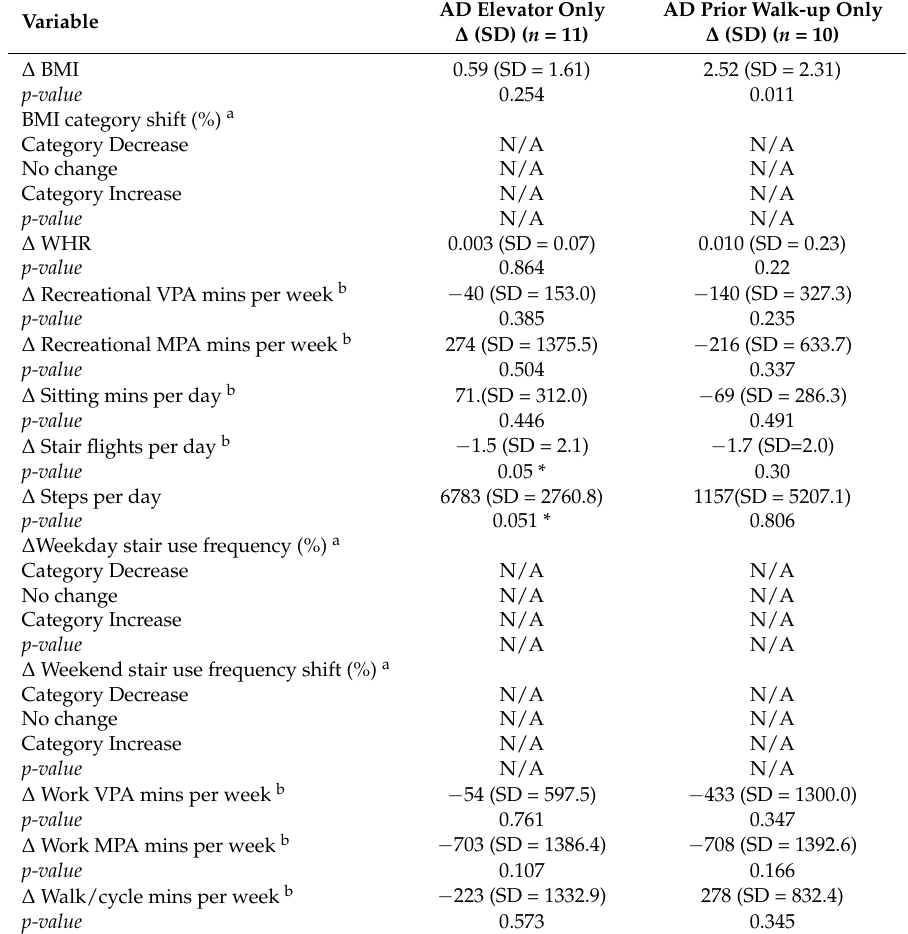
Table 3. Sub-group analyses of AD Building Anthropometric and Physical Activity Response